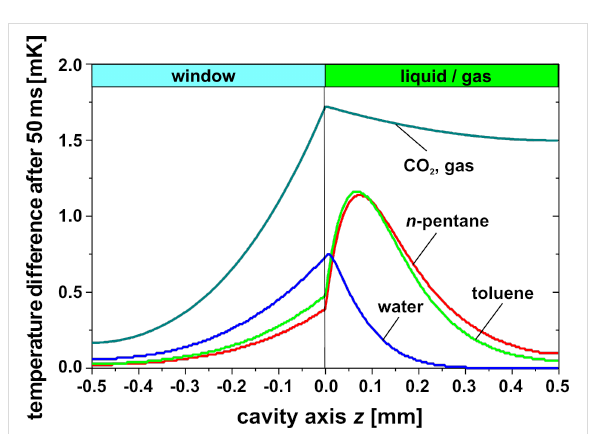
Figure 7: Temperature distribution along the cavity axis 50 ms after the onset of irradiation for different liquids with an IR power density at the outer window surface of 10 W/m 2 , see Figure